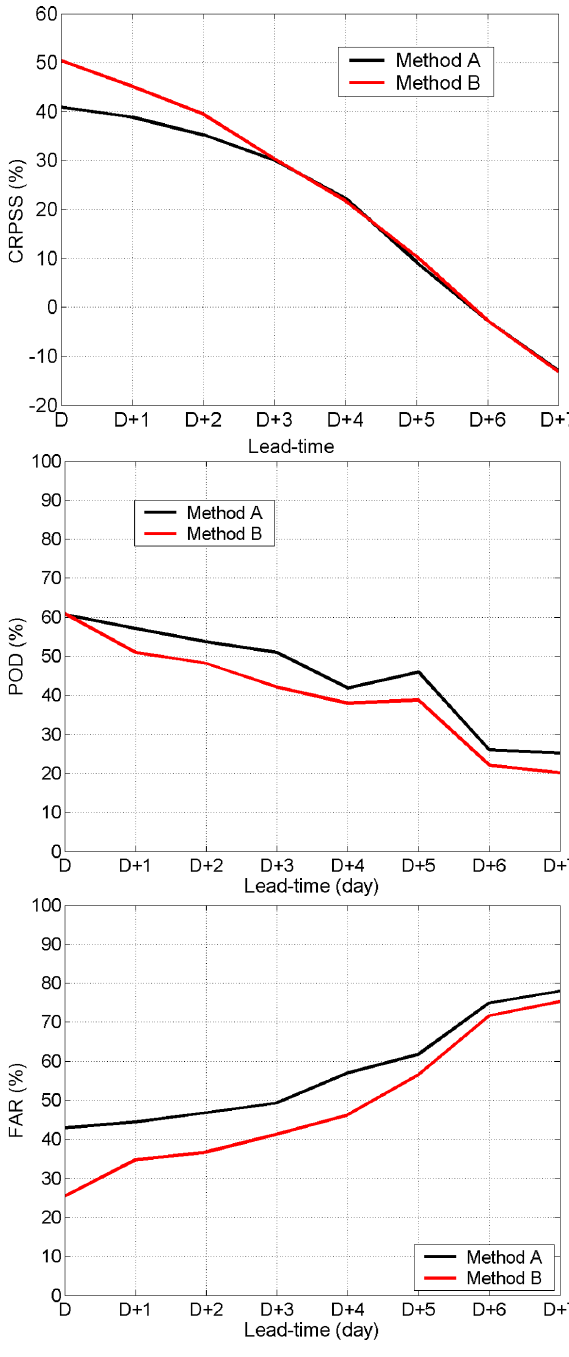
Fig. 3. CRPSS, POD and FAR scores as function of the lead- time, obtained in operational context for the Doubs River basin. POD and FAR scores are computed with a forecast value repre- sented by the 60% quantile of the distribution and for the threshold T = 9 . 1mmday − 1 . We refer to the first day of forecast as t = D